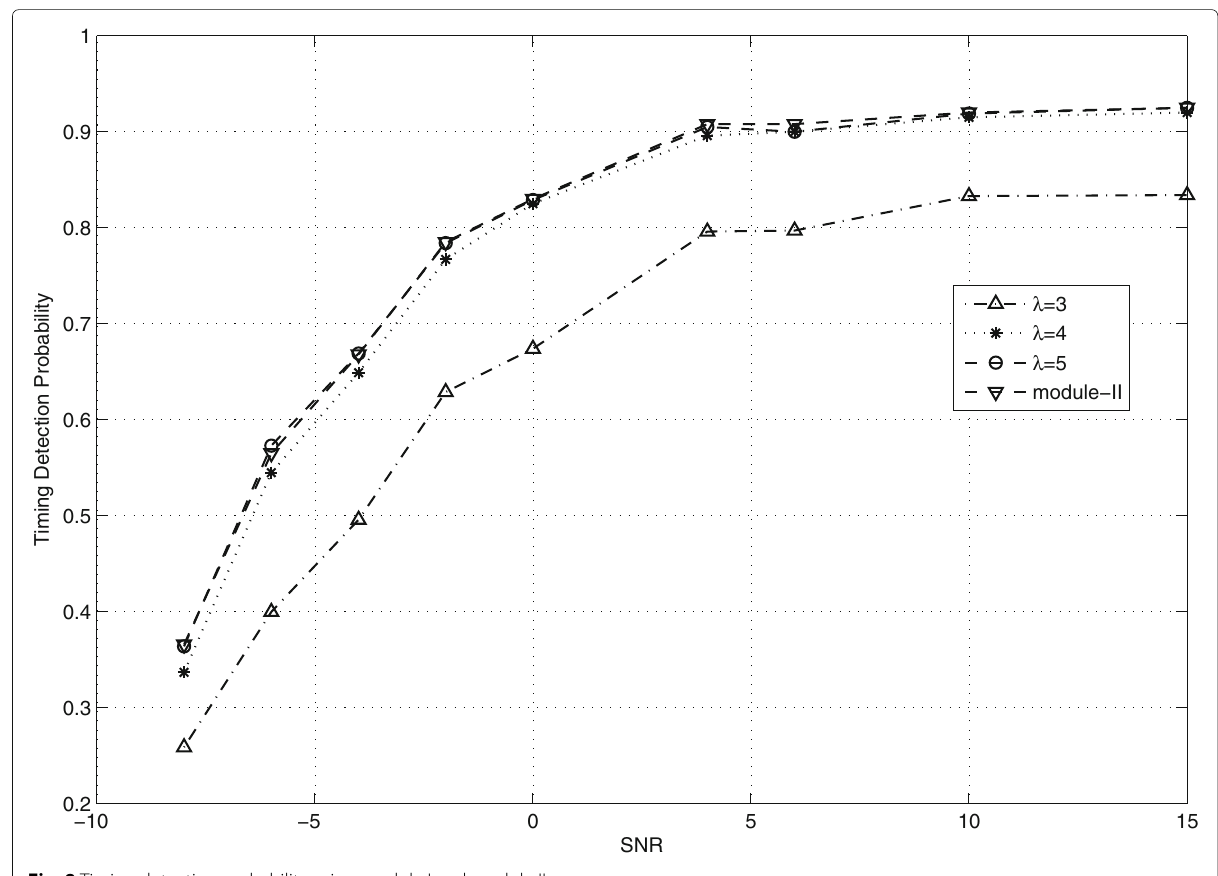
algorithm depends on the frequency domain correlation of the PSS sequences over the 62 subcarriers of each OFDM symbol. The algorithm is more prone to frequency selectivity effects as it depends on the direct correlation with the desired sequence in the frequency domain. It is